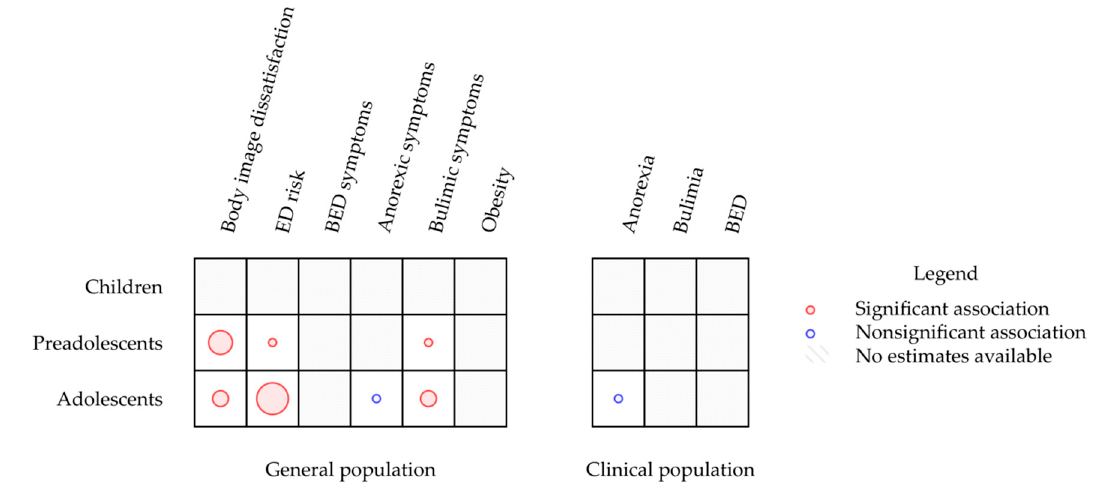
Figure 2. Mapping diagram of examined studies. Note. The map synthesises estimates of the association between EI and eating- and weight-problem-related constructs. Different estimates calculated by single studies are reported separately. The radius of circles is proportional to the number of estimates available regarding the association between EI and the relative construct.